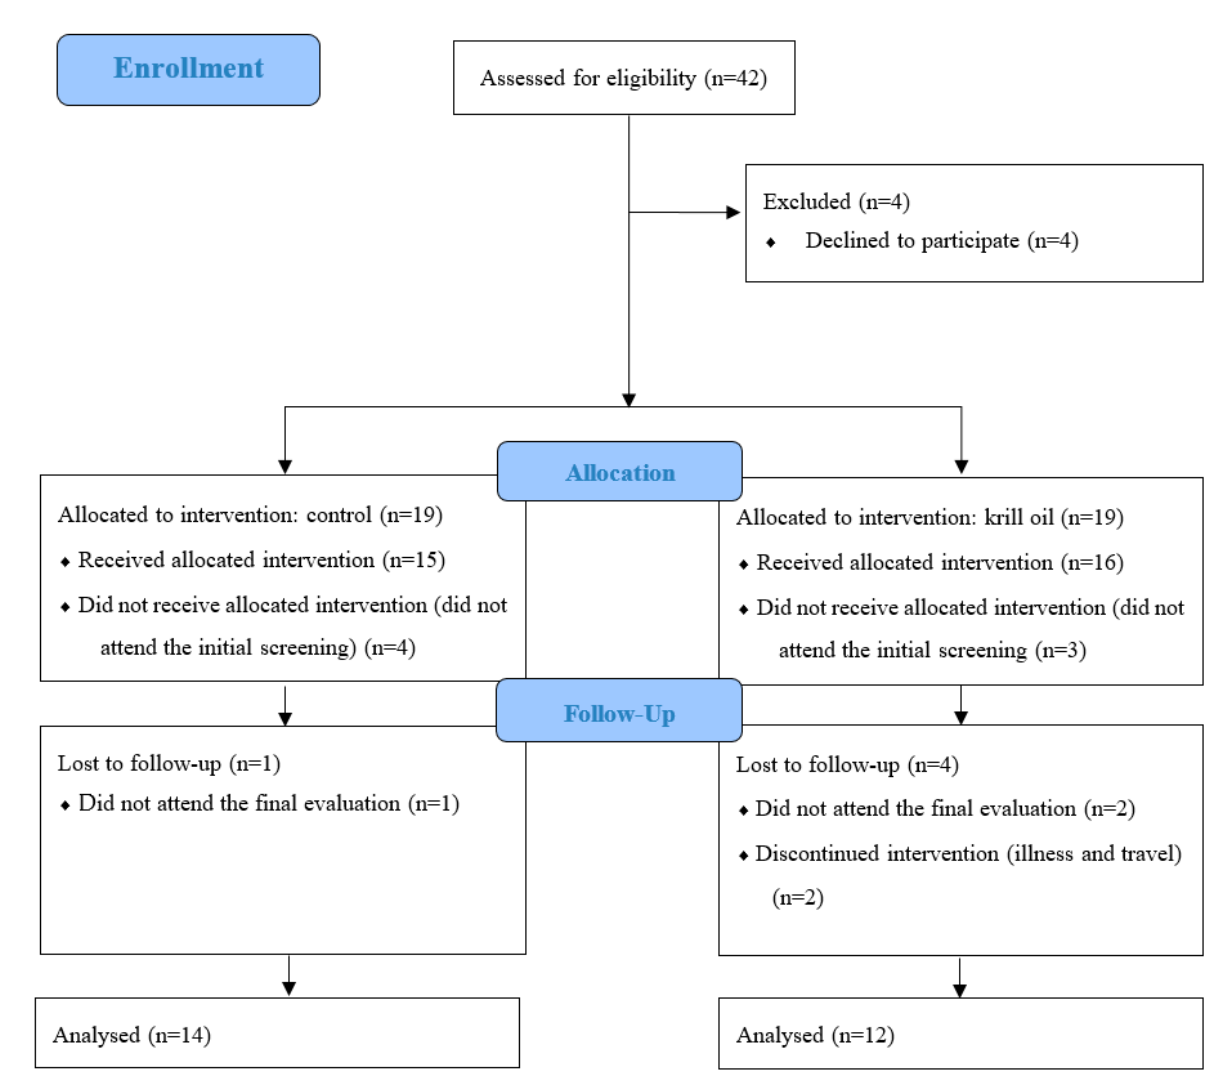
Figure 1. Participant